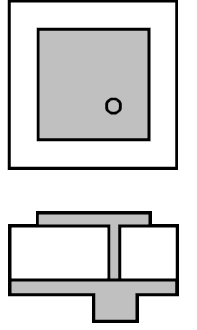
Figure 3. Coaxial probe